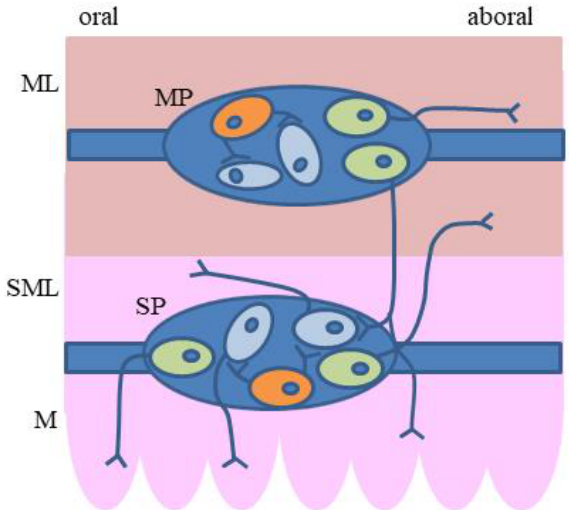
Figure 2. The distribution of two main types of somatostatin (SOM)-positive enteric neurons (secretomotor neurons and interneurons) in the guinea pig intestine: green – SOM-positive secretomotor neurons, orange – SOM-positive interneurons, blue – other neurons, ML = muscular layer, SML = submucosal layer, M = mucosal layer, MP = myenteric plexus, SP = submucous plexus.